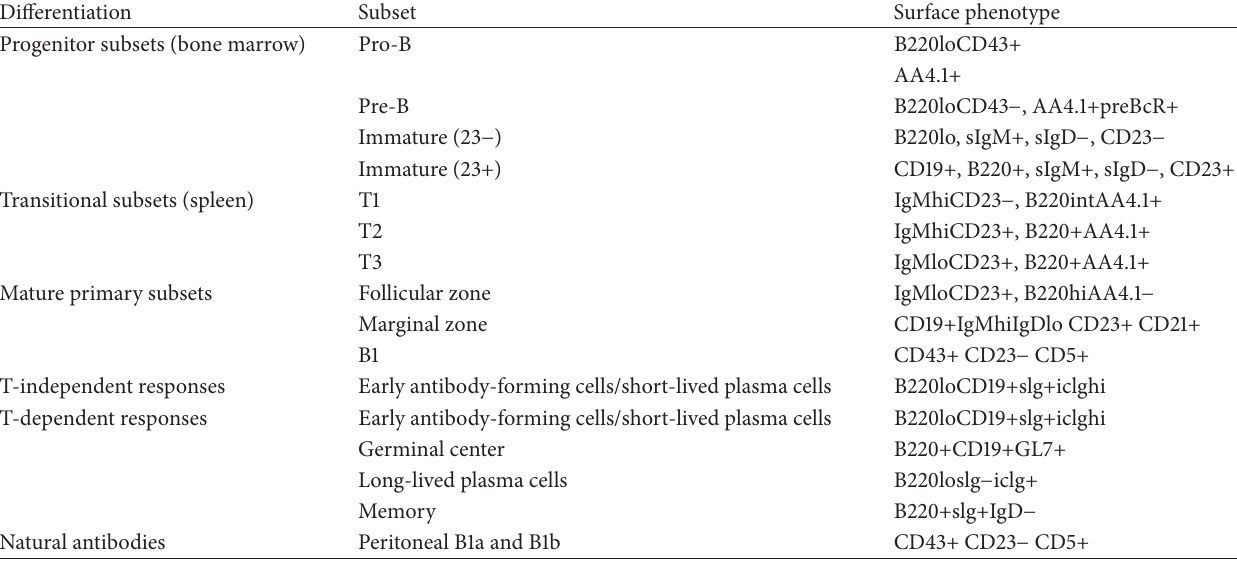
Table 1: Characteristics of primary B cell subsets and their